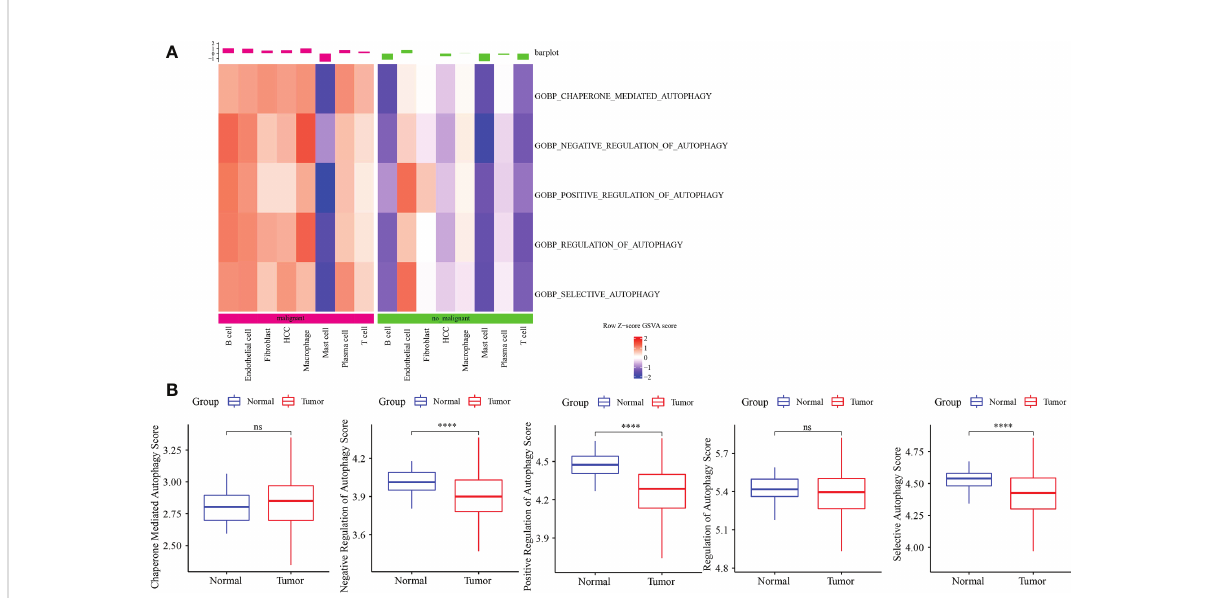
FIGURE 2 Autophagy-related pathway analysis. (A) Five autophagy-related pathways were activated in malignant. (B) The difference analysis of autophagy- related pathways scores in normal and tumor. ****p<0.0001, ns, no signi fi cance.